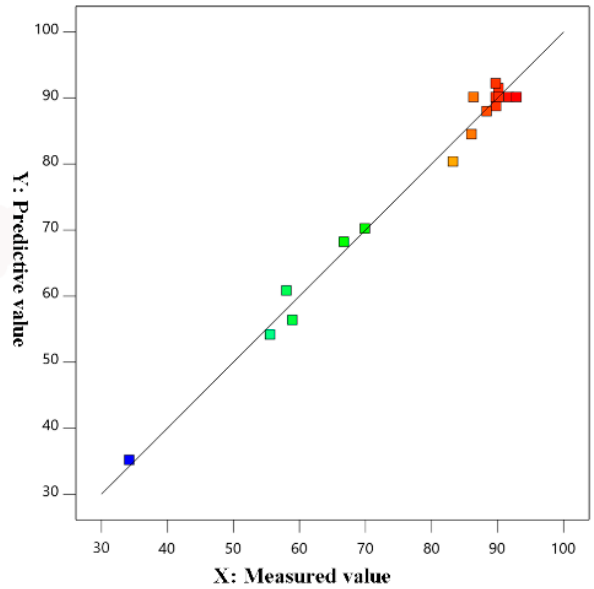
Figure 10. Comparison of actual and predicted values.